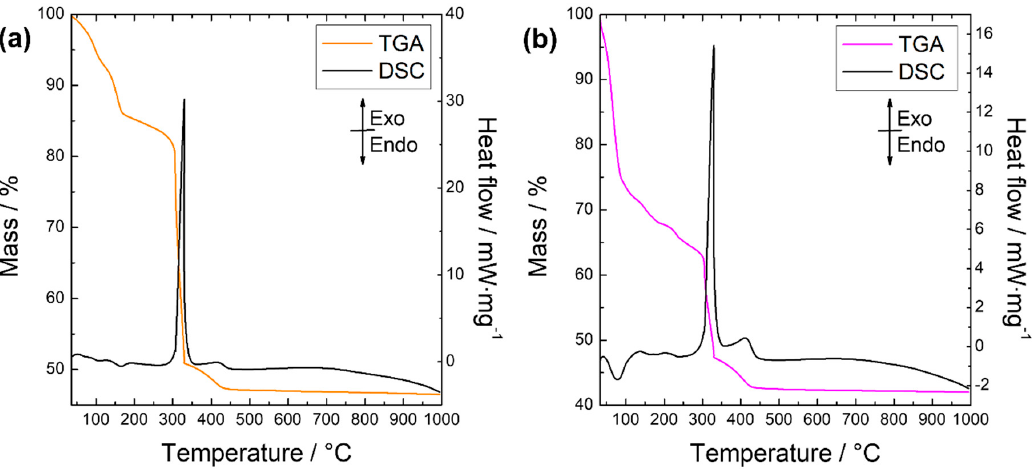
Figure 10. TGA-DSC curves of ( a ) Zn-fel(4)-LSH and ( b ) Zn-fel(4)-LSH/U10 samples.